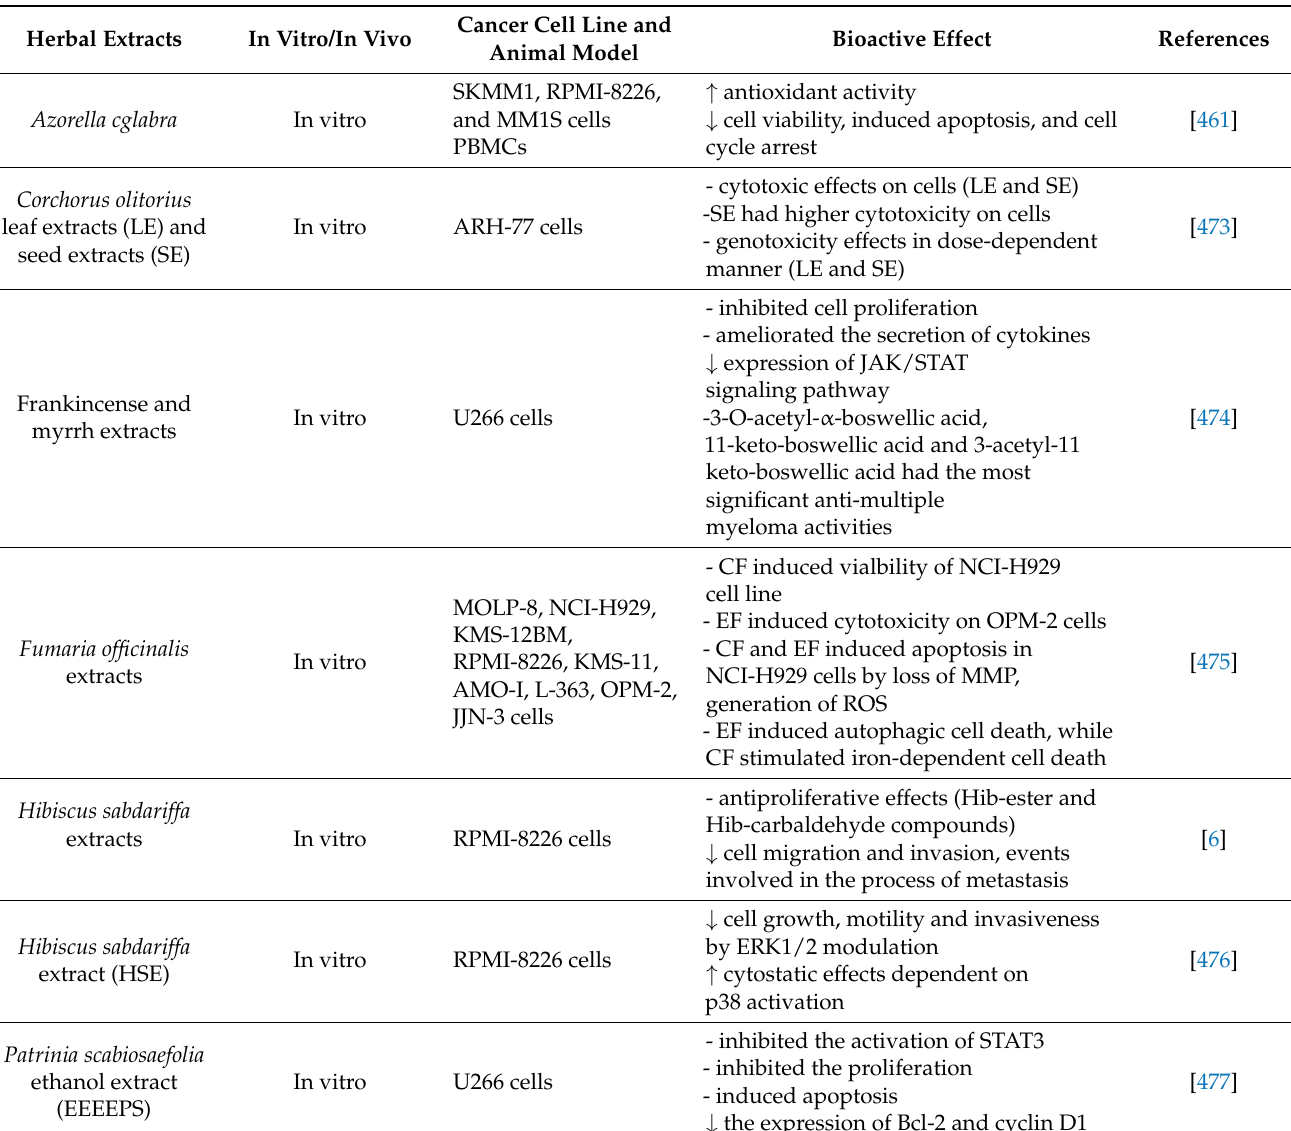
Table 2. Pharmacological effects of different plant extracts in multiple